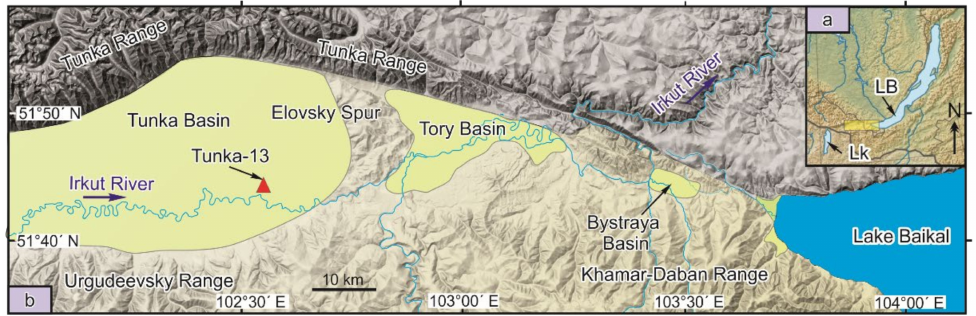
Figure 1. Stretching of the Tunka Rift Valley between the lacustrine Baikal (LB) and Khubsugul (LK) basins ( a ) and the location of the Tunka-13 drill hole in the central part of the rift valley within its largest Tunka Basin ( b ).